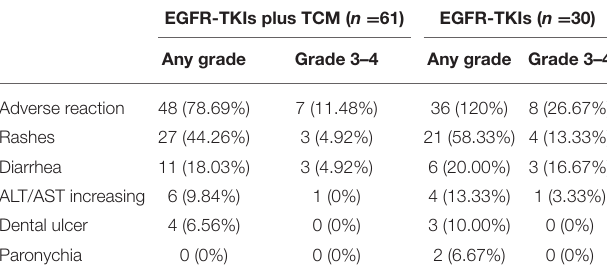
TABLE 3 | Adverse reaction comparison table ( n , %), ( P =